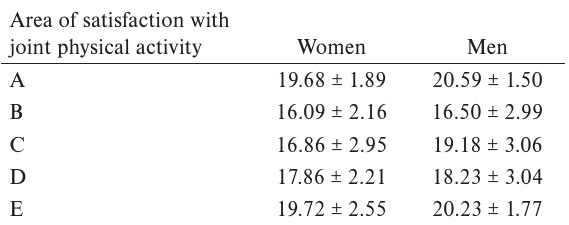
Gender differences in satisfaction with joint physical activity Area of satisfaction with joint physical activity